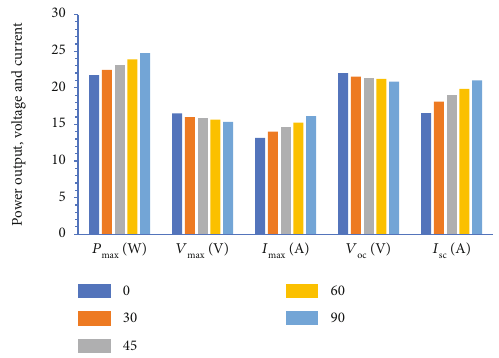
I V I V max , max , max , sc , and oc )